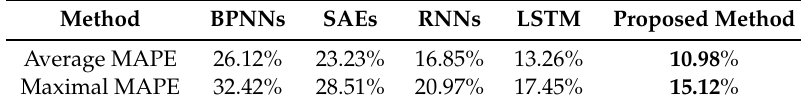
Table 10. Average and maximal MAPEs of the proposed and current methods for short-term load forecasting.